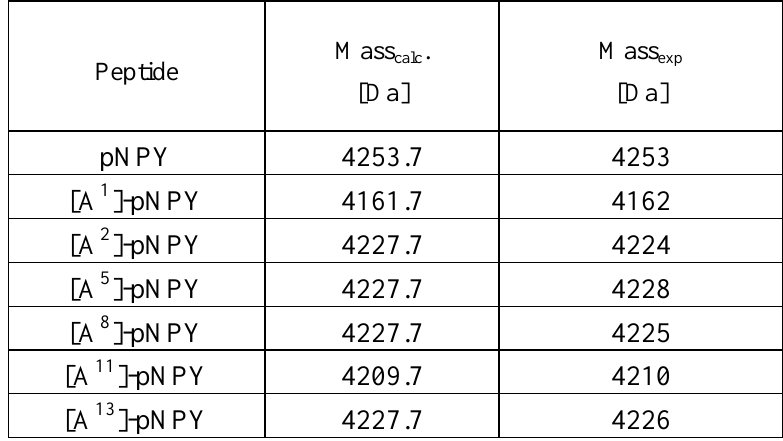
Analytical (top) and biological (bottom) data of amino acid mono-substituted and centrally truncated NPY analogues. In brackets the affinity of the peptide divided by the affinity of pNPY is